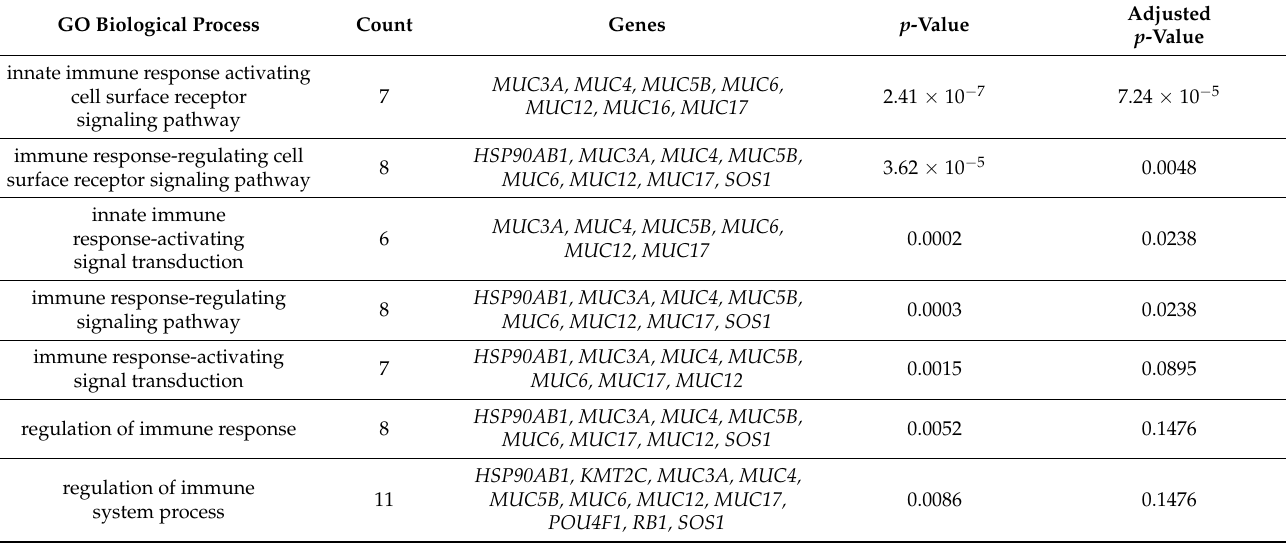
Table 2. GO Biological Process terms related to immune responses were enriched in genes with mutations occurred in T47D